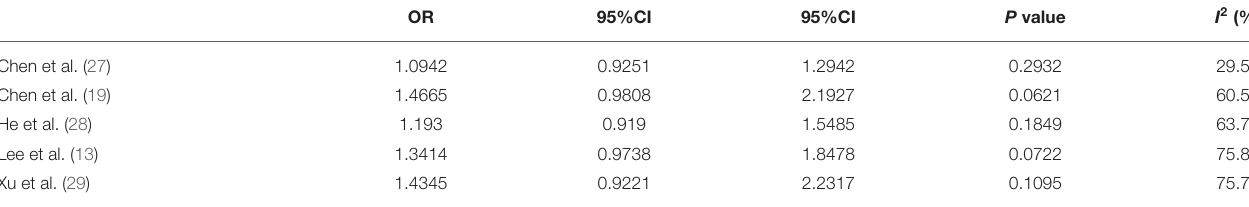
TABLE 5 | Sensitivity analysis for the association of childhood overweight/obesity and early puberty in boys.